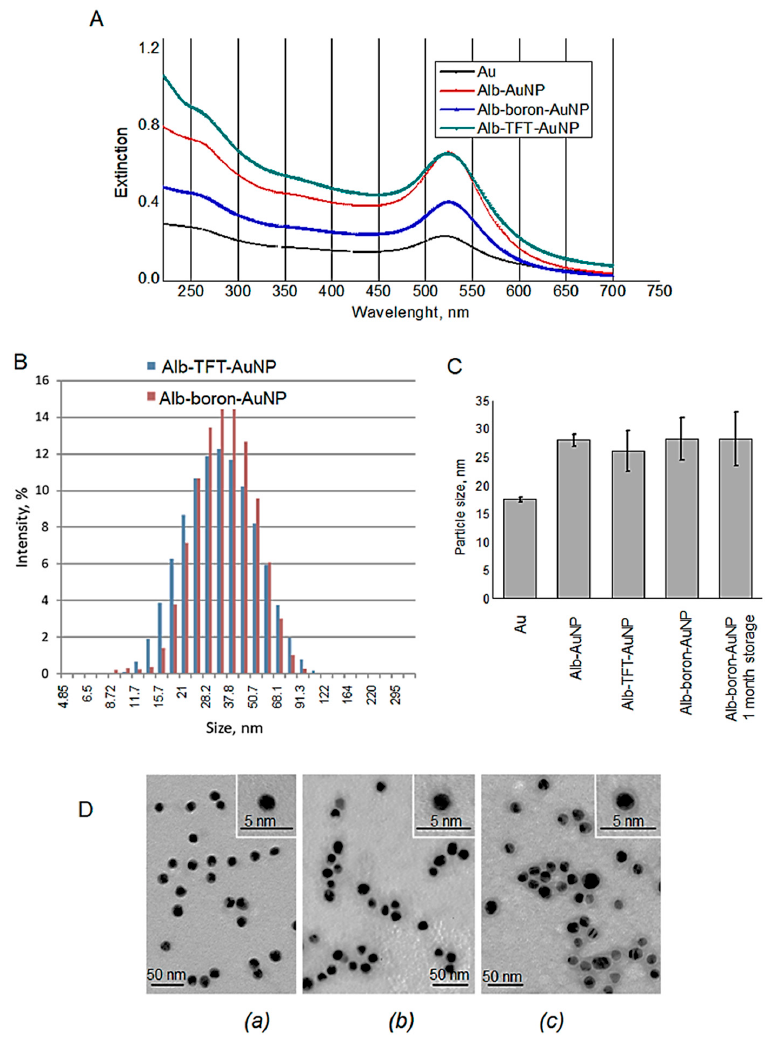
Figure 2. ( A ) UV–VIS spectra corresponding to citrate-stabilized AuNPs: AuNPs-citrate, black, λ max = 521 nm; human serum albumin (HSA)-Au, red, λ max = 525 nm; alb-TFT-AuNP, green, λ max = 524 nm and alb-boron-AuNP, blue λ max = 525 nm for the gold plasmon; λ max = 260 nm corresponds to compound TFT; ( B ) size distribution ranges as determined by dynamic light scattering (DLS) (volume distribution) for alb-TFT-AuNP, and alb-boron-AuNP; ( C ) particle size of AuNPs; ( D ) representative TEM images of AuNPs-citrate ( a ), alb-TFT-AuNP ( b ) and alb-boron-AuNP ( c ). Negative staining with phosphotungstic acid (pH 3.0). Bars correspond to 5 nm (inset) and 50 nm (main image).